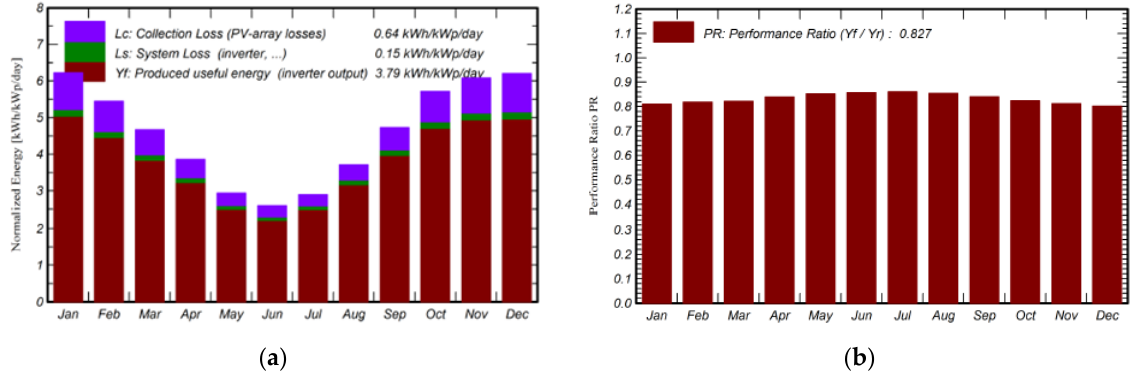
Figure 8. PV production: ( a ) normalized production per kWp installed; ( b ) performance ratio.